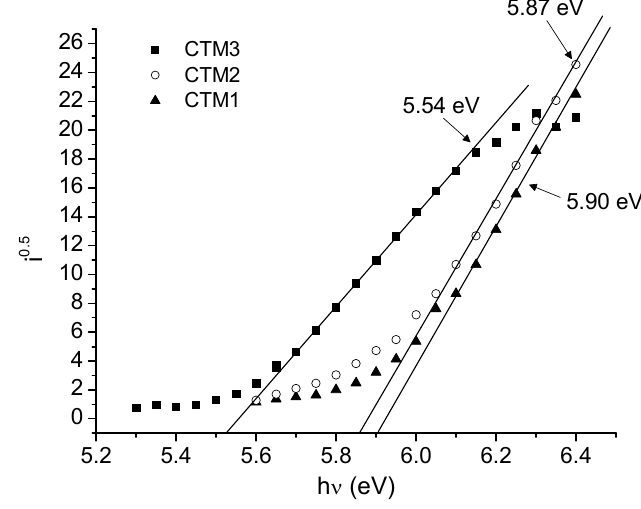
Figure 3. Photoemission spectra of the amorphous films of CTM1 – 3 measured in air.